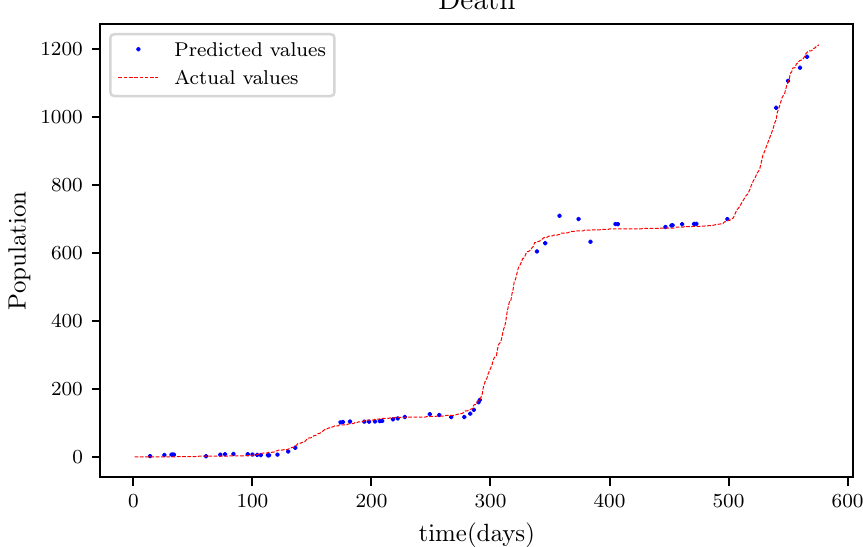
Figure 14. The graph shows a comparison of the predicted deceased population values and the actual data of the deceased population for a 130 data